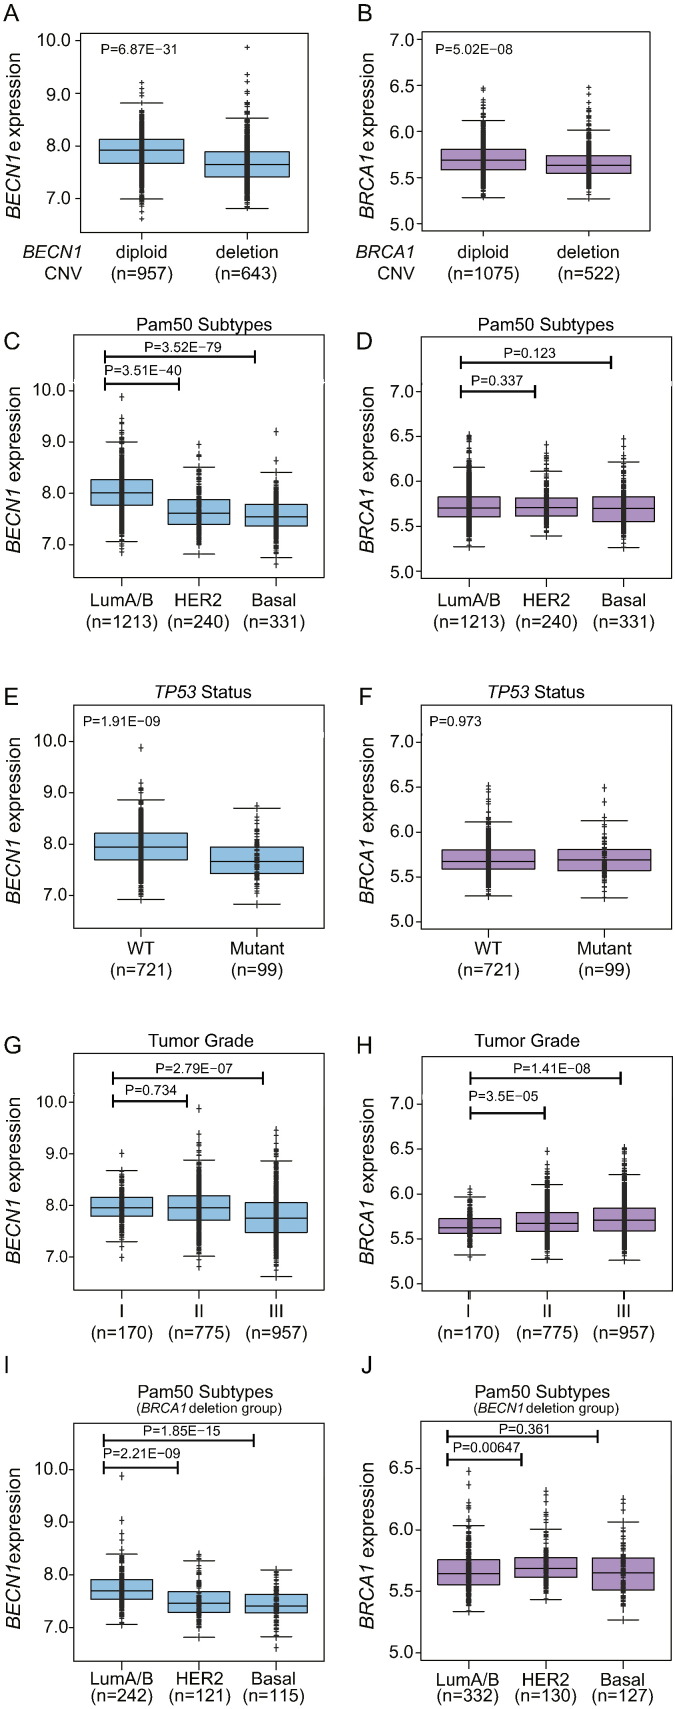
Boxplot showing the distribution of BECN1 expression and BRCA1 expression in METABRIC according to the copy number status (panels A and B), PAM50 subtypes (panels C and D), TP53 mutation status (panels E and F), tumor grade (panels G and H), and PAM50 subtypes in copy number loss subgroups (panels I and J). The boxes represent the median (black middle line) and the 25th–75th percentiles (lower and upper box borders). Units for gene expression represent log2 intensities of Illumina array values (see Methods).